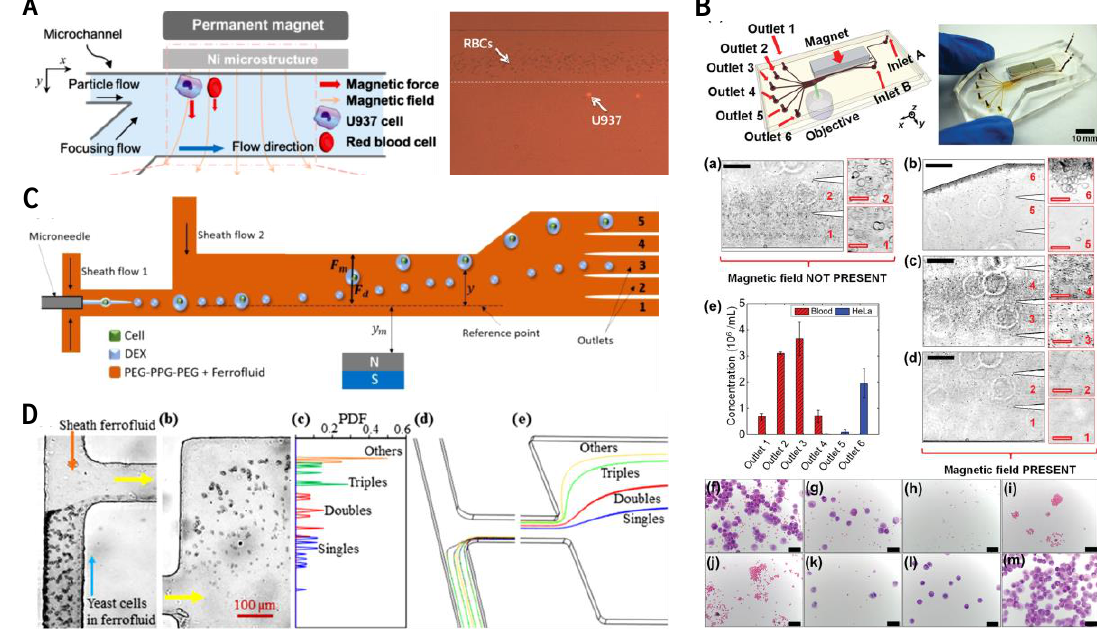
Figure 10. Diamagnetic particle separation in the flow of magnetic fluids with one-sheath-flow focusing. ( A ) Schematic of the separation mechanism (left) and the microscopic image of U937 cells separated from red blood cells (RBC) in 40 mM Gd−DTPA (right). Adapted with permission from Shen et al. [127], © 2012 American Chemical Society. ( B ) Schematic and picture of the microfluidic chip (top) and experimental images demonstrating the separation of HeLa and RBC cells (bottom). Adapted with permission from Zhao et al. [128], © 2015 Wiely-VCH. ( C ) Schematic illustration of diamagnetic separation of cell-containing droplets from empty droplets in the flow of ferrofluid with surfactants. Adapted with permission from Navi et al. [129], © 2018 The Royal Society of Chemistry. ( D ) Experimental (left) and numerical (right) demonstrations of ferrofluid-based magnetic fractionation of drug treated yeast cells in a T-shaped microchannel. Adapted with permission from Chen et al. [130], © 2017 American Institute of Physics.